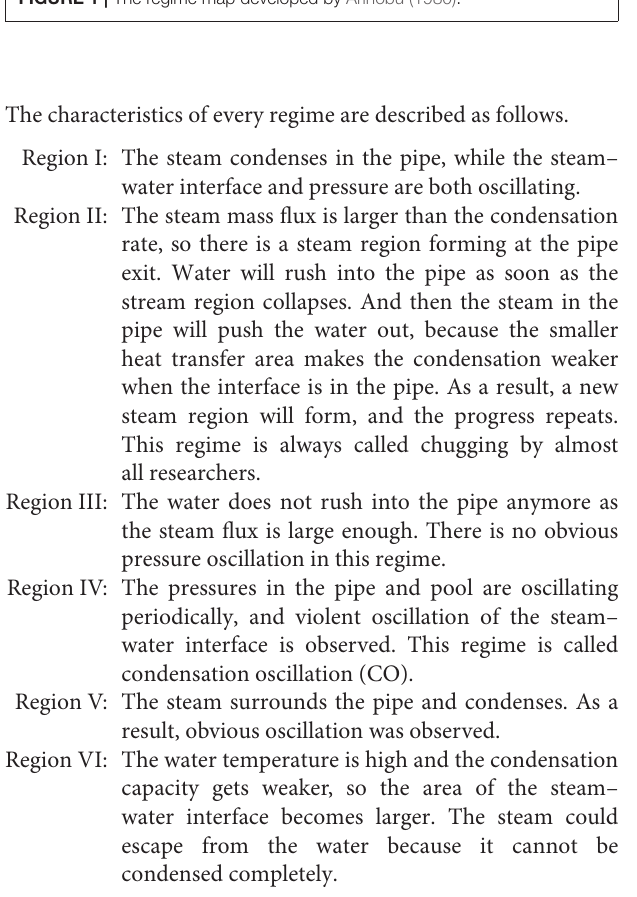
FIGURE 1 | The regime map developed by Arinobu (1980).